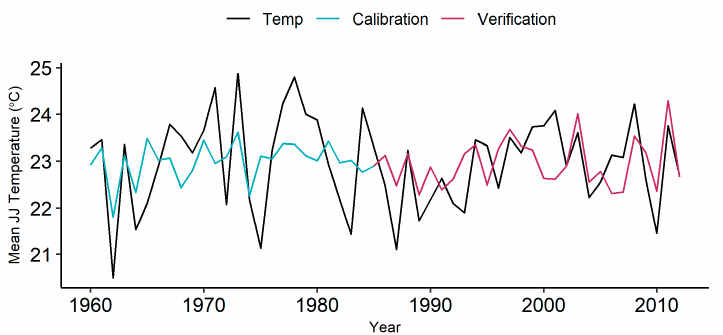
Figure 4. Comparison of the actual and reconstructed mean June–July temperature of Srinagar for the common period 1960–2012.